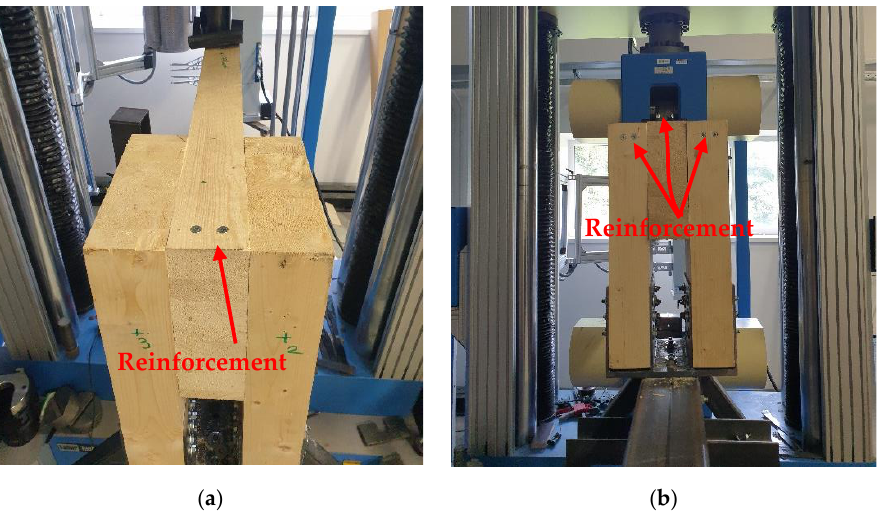
Figure 12. Illustration of the reinforcement of segments of individual experiments: ( a ) reinforcement of the rung; and ( b ) reinforcement of the rung and struts (stands).